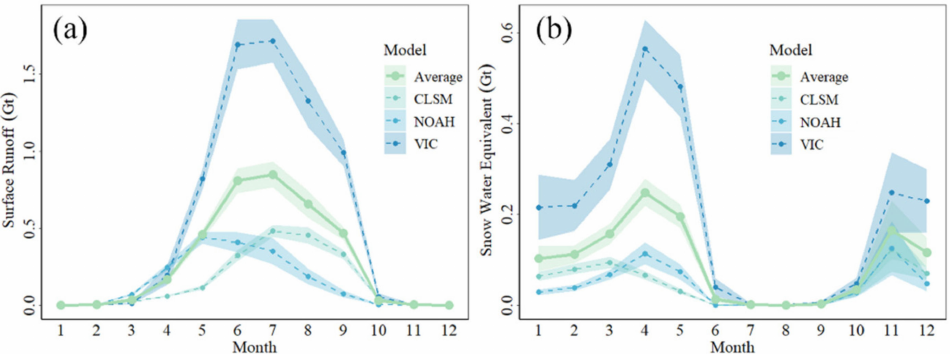
Figure 6. ( a ) Monthly surface runoff and ( b ) SWE derived from Noah, VIC, and CLM and their average upstream basin values from 2007 to